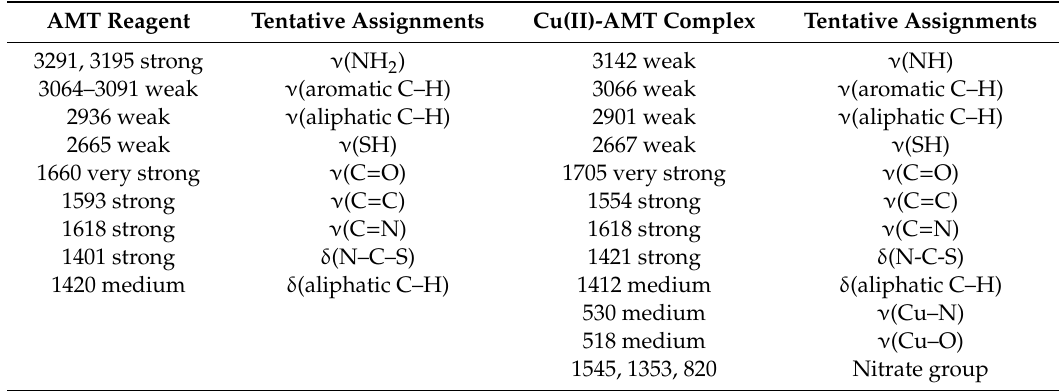
Table 1. FT-IR frequencies (cm − 1 ) and tentative assignments of AMT and the Cu(II)-AMT